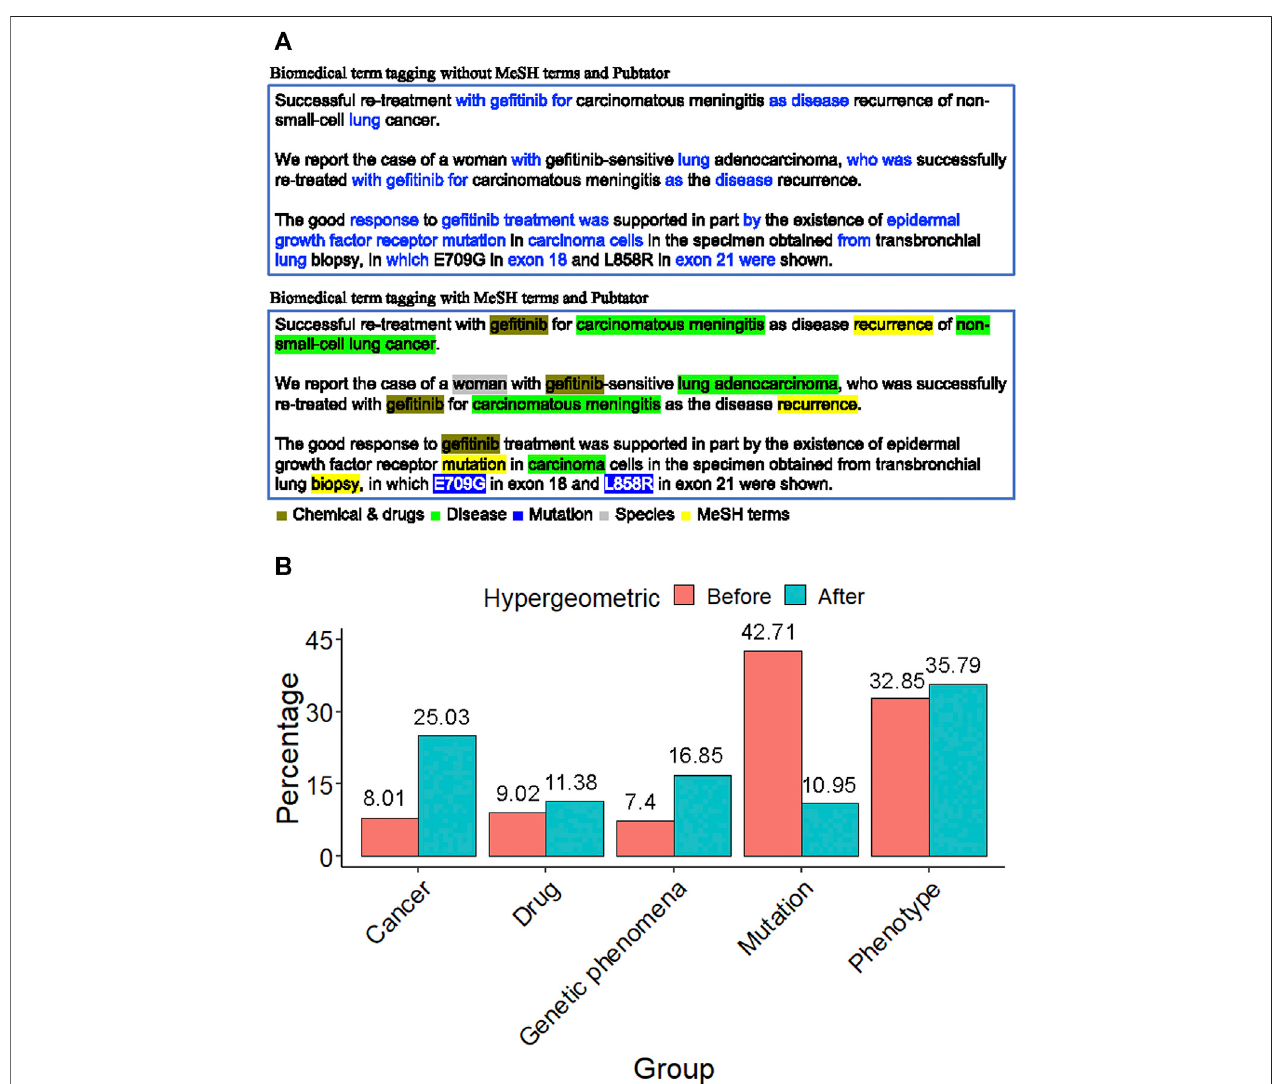
FIGURE 3 | Biomedical term extraction (A) The term feature ofan EGFR-related abstract. The former was fi lled with many redundant words, such as with, for, and after. The latter contains lots of biologically meaningful terms, such as ge fi tinib (chemical), non-small cell lung cancer (disease), L858R (mutation), the woman (species), and recurrence (MeSH). This phenomenon shows that the tagging approach with MeSH and PubTator terms is essential to gene term-feature extraction. (B) The proportiondistributionbarchartoftheMSK-IMPACT panelineachtermfeaturegroupbeforeandafterthehypergeometricdistributiontest.Itshowsthatafterterm feature selection, the proportion of the term feature groups of interest increases, such as cancer, drug, genetic phenomena, and phenotype.